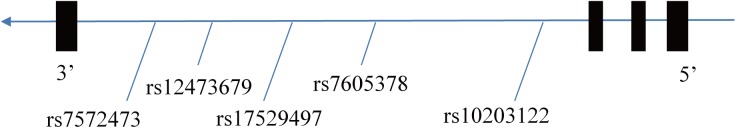
Graphical overview of the genotyped human FTCDNL1 gene.